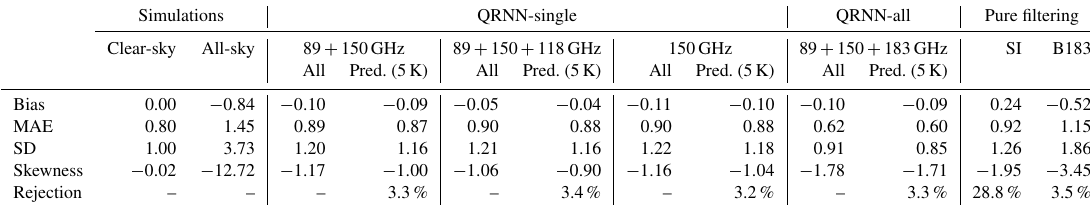
Table 4. The error statistics for deviations of point estimates from NFCS simulations. Results are for different QRNN experiments for MWHS-2 channel 14 (see Sect. 3.1). The statistics for all-sky and clear-sky simulations are also provided. The label “All” denotes the entire dataset of predicted point estimates, while “Pred. (5K)” refers to the predicted point estimates but where cases with cloud correction greater than 5K are excluded. “Rejection” indicates the percentage of cases excluded. The last two columns show the statistics obtained after filtering cloudy cases according to SI and scheme by Buehler et al. (2007) (B183). Bias, MAE and SD are in K; skewness is dimensionless. Simulations QRNN-single QRNN-all Pure filtering Clear-sky All-sky 89 + 150GHz 89 + 150 + 118GHz 150GHz 89 + 150 + 183GHz SI B183 All Pred. (5K) All Pred. (5K) All Pred. (5K) All Pred.